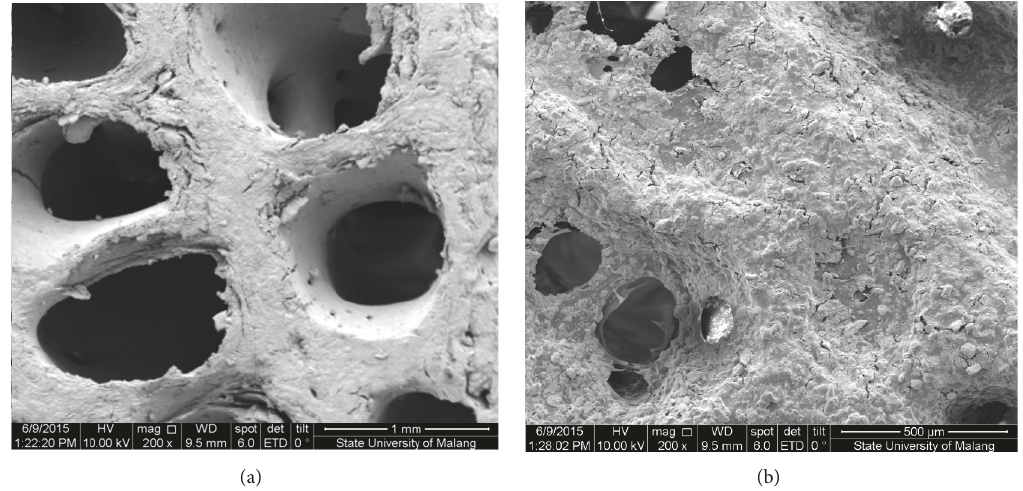
Figure 5: SEM of scaffold HA results (a) before the injection with IBS, magnification at 200x; (b) after injection of IBS and setting, magnification at 200x.